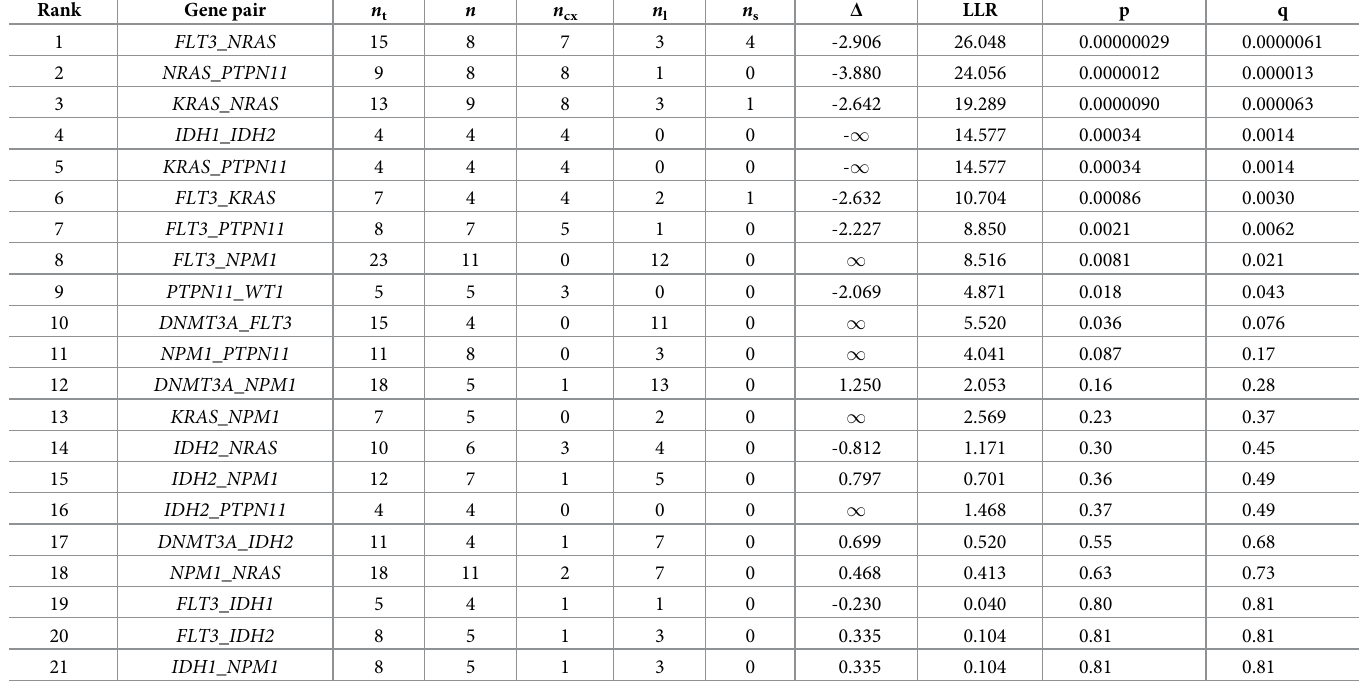
Table 1. GeneAccord combined results for the AML cohort [12]. Ranked list of the gene pairs tested with the GeneAccord exact combined test on the cohort of 123 AML patient samples. For each gene pair, the column n t is the total number of patients exhibiting both gene mutations, n the number of those patients whose trees are not linear or star shaped and n cx the number of times the genes are clonally exclusive within those n trees. The columns n l and n s contain the number of linear and star trees. Δ is the clonal exclusivity score indicating enrichment of clonal co-occurrence (positive) or clonal exclusivity (negative) with ± 1 corresponding to hitting the numerical optimisation bounds. LLR is the log-likelihood ratio statistic, p is the p-value and q the adjusted p-value after Benjamini-Hochberg correction. Only gene pairs with n > 3 are